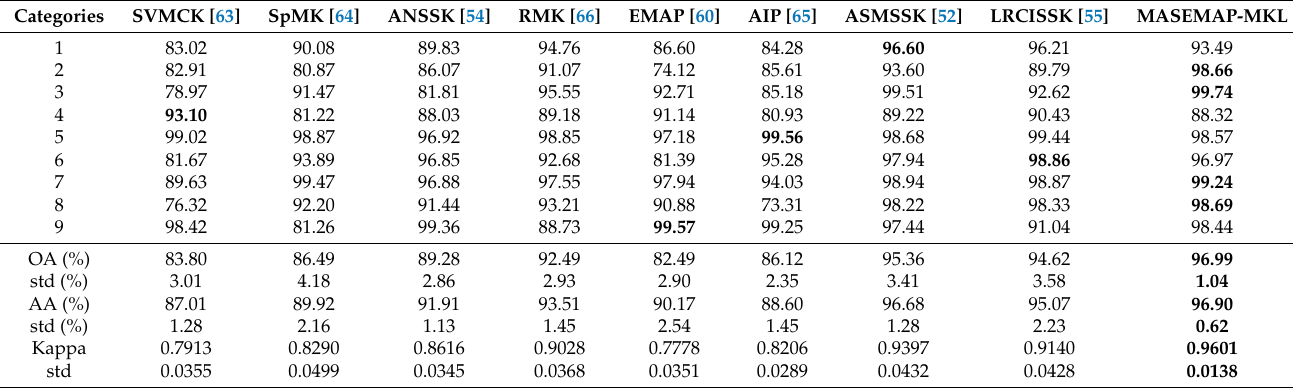
Table 3. Average classification accuracy (%) of all methods on the University of Pavia image with 15 labeled samples per class (the optimal results are highlighted in bold).